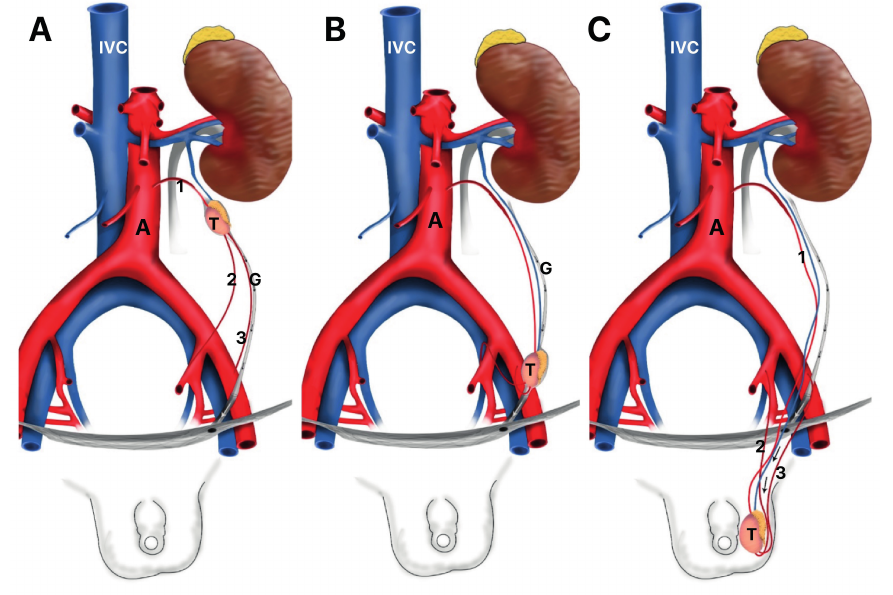
Figure 4 - Schematic drawing showing the steps of testicular migration and the testicular arteries. A) Testis (T) in high abdominal positon, we can observe that the testicular artery (1) is short and the vasal artery (2) and cremasteric artery (3) are longer; B) Testis in abdominal position near the internal inguinal ring and C) Testis in scrotal position, G- gubernaculum, A- Aorta Artery and IVC- Inferior Vena